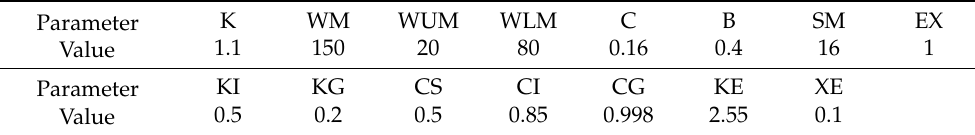
Table 3. Parameters of the Xin’anjiang model in the Zhuji